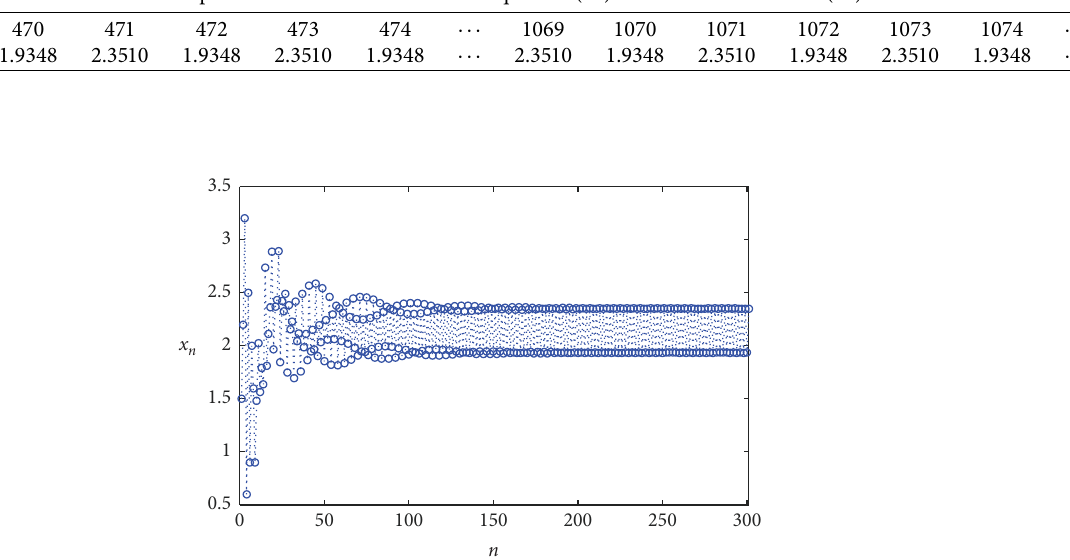
Figure 2: Te solution of equation (27) with the initial values (28) converges to a 2-periodic solution of equation